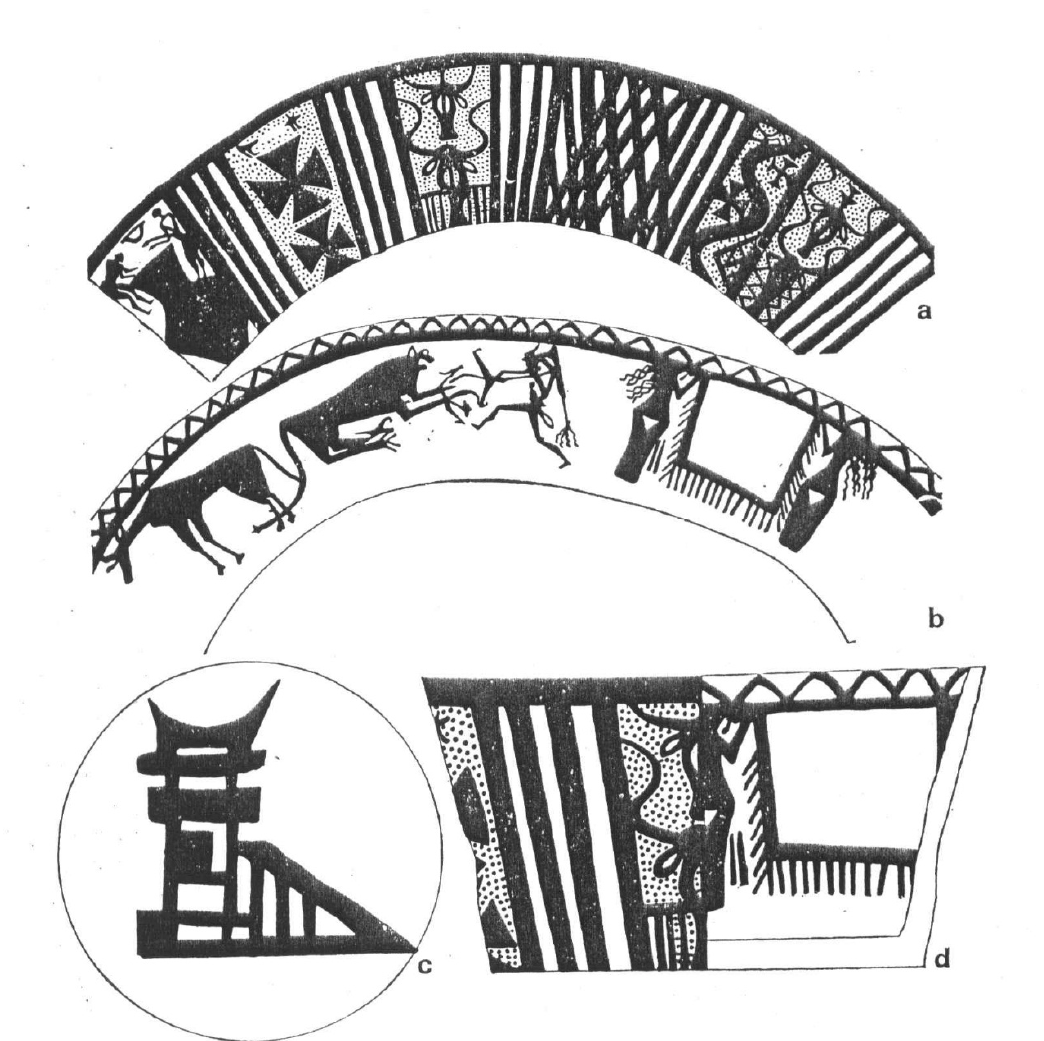
Figure 3. Bowl from Arpachiya, depicting bulls, naked women and rain (Hijara et al. 1980: Figure